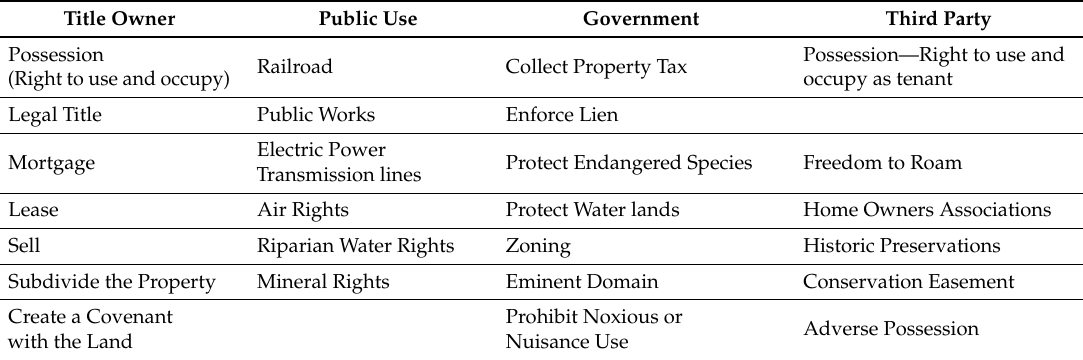
Table 2. Bundles of Property Rights. Source: Adapted for PNG from